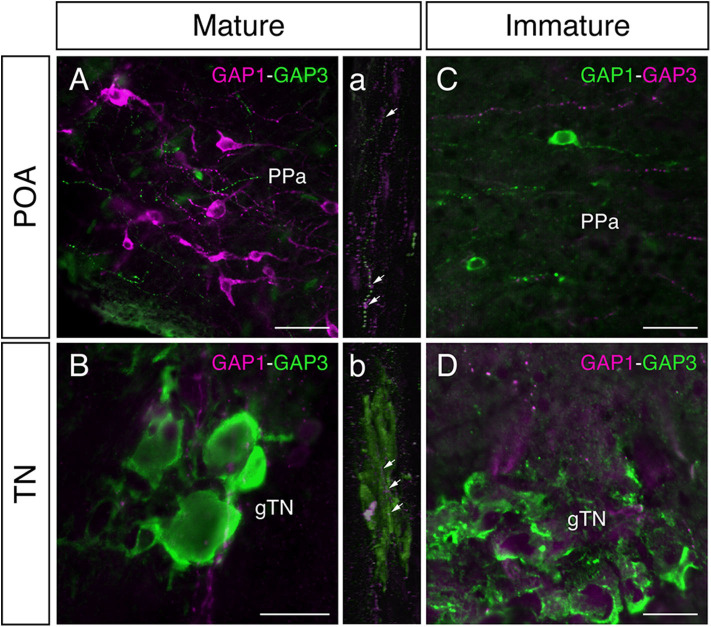
Photomicrographs of double immunofluorescence of GnRH-GAP1 and GnRH-GAP3 in the brain of sexually mature and immature male tilapia. In mature males, GnRH-GAP3-immunoreactive (ir) neuronal processes (green) are closely located to GnRH-GAP1-ir cell somata (magenta) in the anterior part of the parvocellular preoptic nucleus (PPa) of the preoptic area (POA, A), while in the terminal nerve ganglion (gTN), GnRH-GAP1-ir neuronal processes (magenta) are also closely located to GnRH-GAP3-ir cell somata (green) the (B). Confocal scanning of these regions further confirmed the proximities of GnRH-GAP1 neuronal processes with GnRH-GAP3 cell somata (a,b). In contrast, neuronal interaction between GnRH-GAP1 and GnRH-GAP3 were not seen in immature males (C,D). Scale bars = 20 μm.